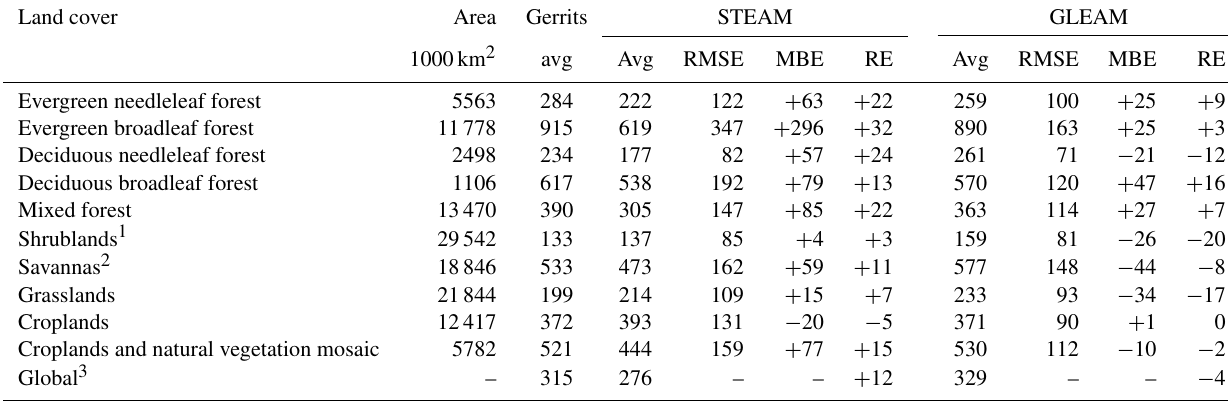
Table 5. Comparison of transpiration estimated by Gerrits’ model to STEAM and GLEAM through average, RMSE, MBE, and RE per land cover type. Negative MBE and RE show Gerrits’ model underestimates evaporation and vice versa. Average, RMSE, and MBE are in mmyr − 1 and RE is in %.